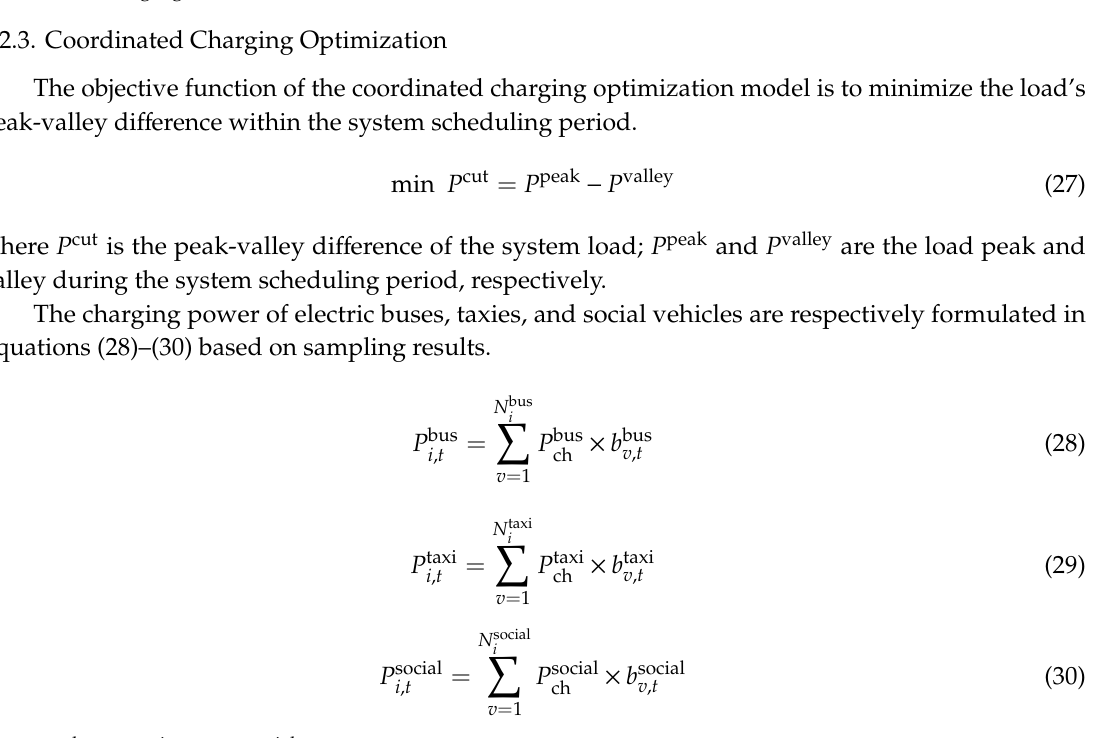
Figure 5. The initial SOC and initial charging time sampling results of taxis; ( a )the initial SOC; ( b )the initial charging time.